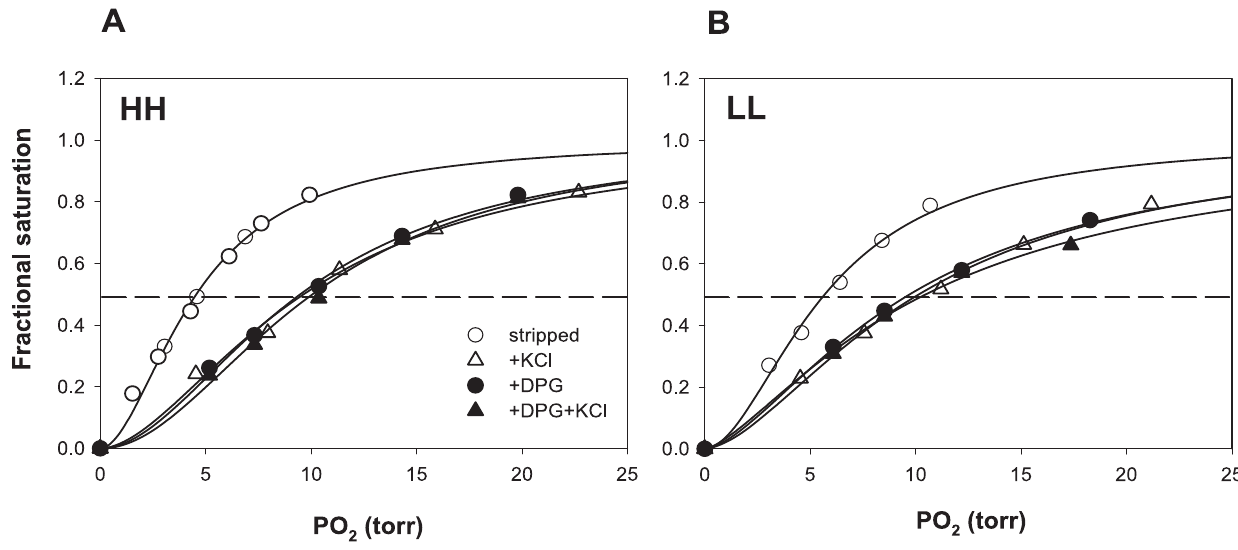
Figure 4. O 2 -binding properties of purified deer mouse rHbs. Panels A and B show O 2 equilibrium curves for purified rHbs HH and LL, respectively. The rHbs HH and LL were expressed in the JM109 (DE3) E. coli strain at 28 u C for 16 hr with co-expression of the pCO-MAP plasmid. O 2 - binding measurements were conducted at pH 7.4 at 37 u C in presence and absence of allosteric cofactors (0.1 M Cl 2 , 0.1 M Hepes, 2.0-fold ratio DPG / rHb tetramers and 0.2 mM heme). Horizontal lines denote the half-saturation value for each